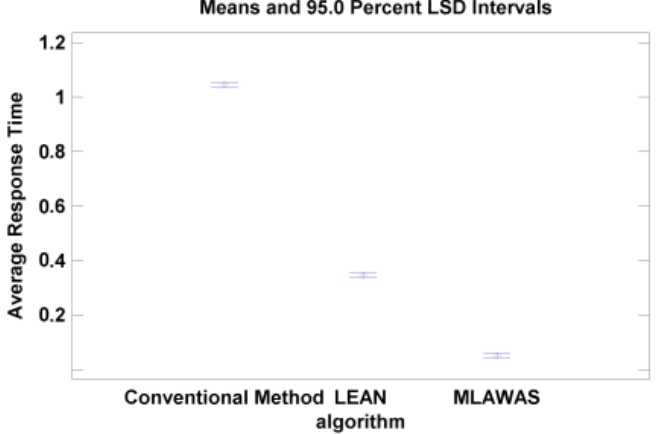
Figure 13. Average Response Time of Workload Without Round-Trip and Migration Delay.